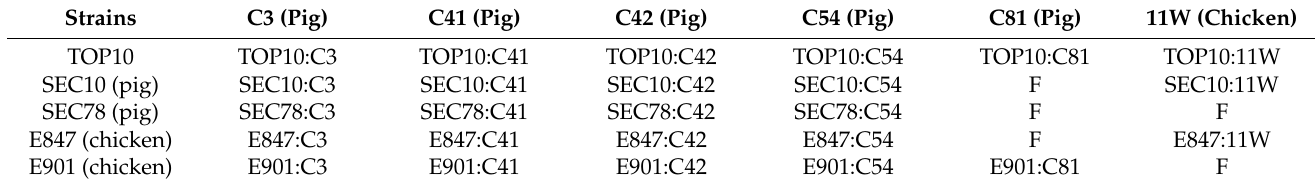
Table 1. Information of the selected plasmids and host bacteria. The first row of the table represents the six plasmids, and the first column of the table represents the five host bacteria. The six plasmids were electrotransformed into the five host bacteria respectively, and the successful transformants were named as “host bacteria:plasmid”.